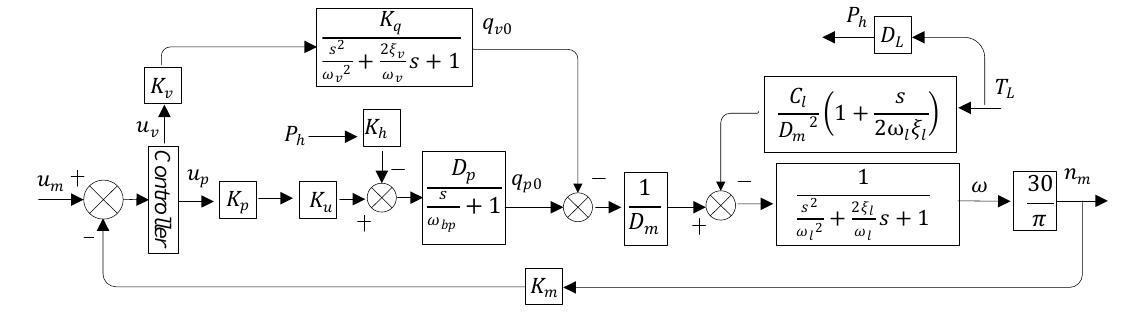
Figure 3. Block diagram of LVPC